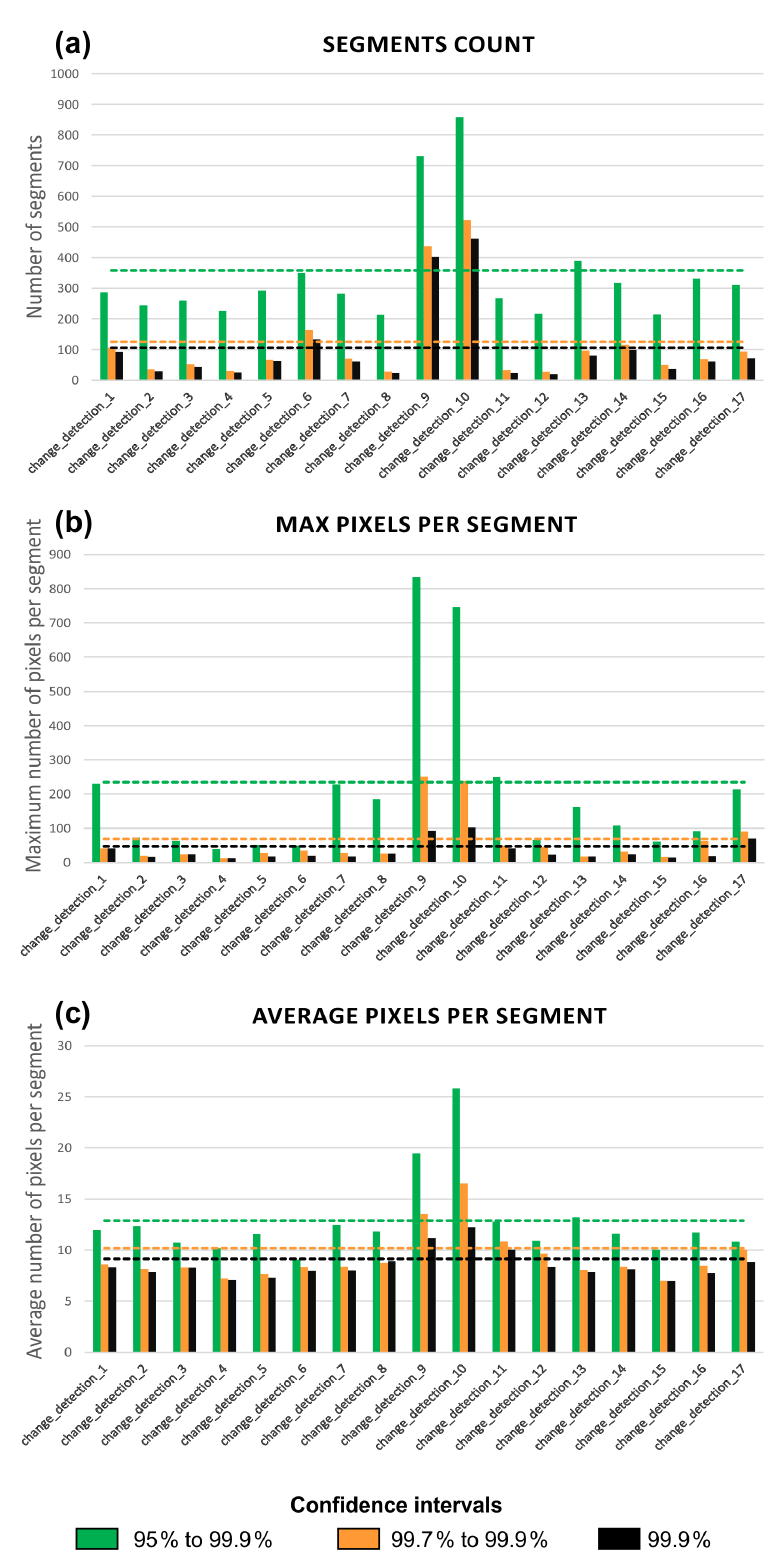
Figure 5. Statistics of the segments identified for each change detection. (a) Number of segments with more than 5 pixels. (b, c) Maximum and average number of pixels per segment. Peaks of the change detections 9 and 10 indicate the occurrence of widespread land cover changes. The dashed lines show the 95 ◦ percentiles of the distributions (not including change detections 9 and